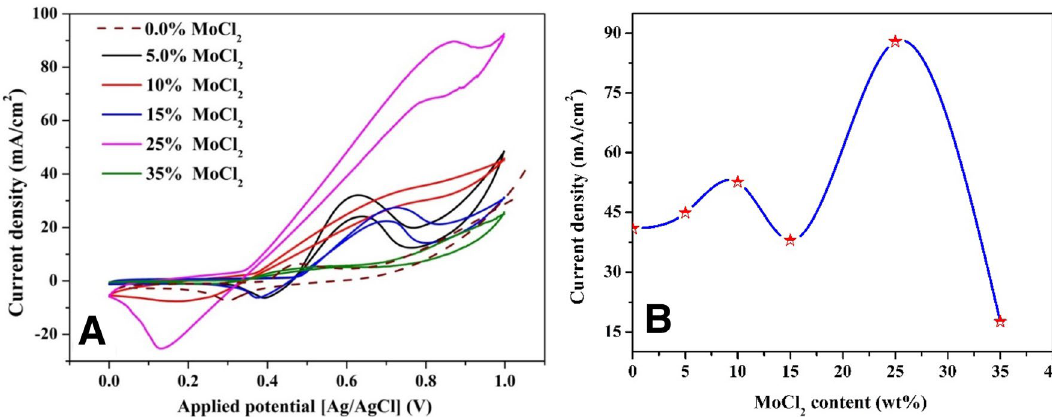
Figure 8. Cyclic voltammograms using the prepared electrodes in presence of 0.33 M urea (in 1.0 M KOH at scan rate of 50 mV/s and 25 °C) ( A ) and influence of molybdenum precursor content in the initial electropsun solution on the maximum current density ( B